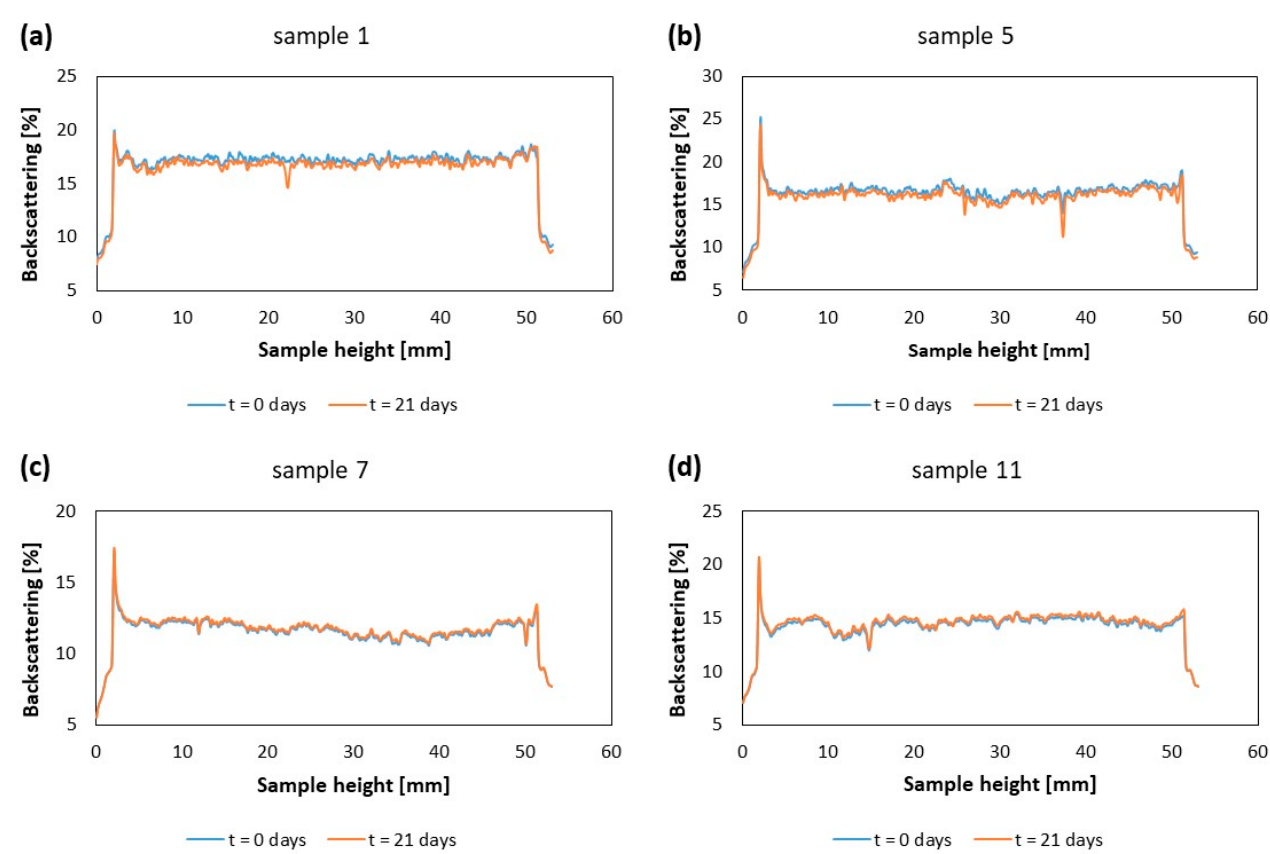
Figure 3. Backscattering (%) profiles of the obtained SLN formulations as a function of sample height (mm) analyzed over 21 days of storage: ( a ) system 1; ( b ) system 5; ( c ) system 7; ( d ) system 11.